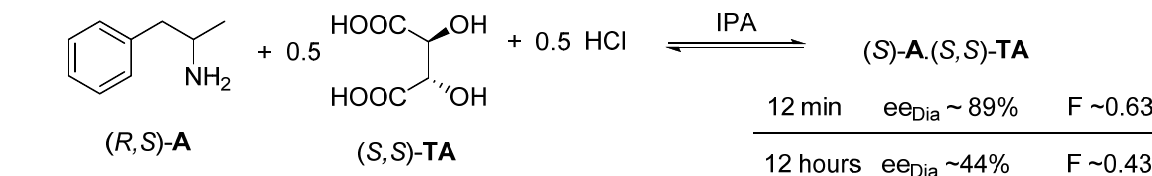
Figure 8. Almost instantaneous effect of the kinetic control.